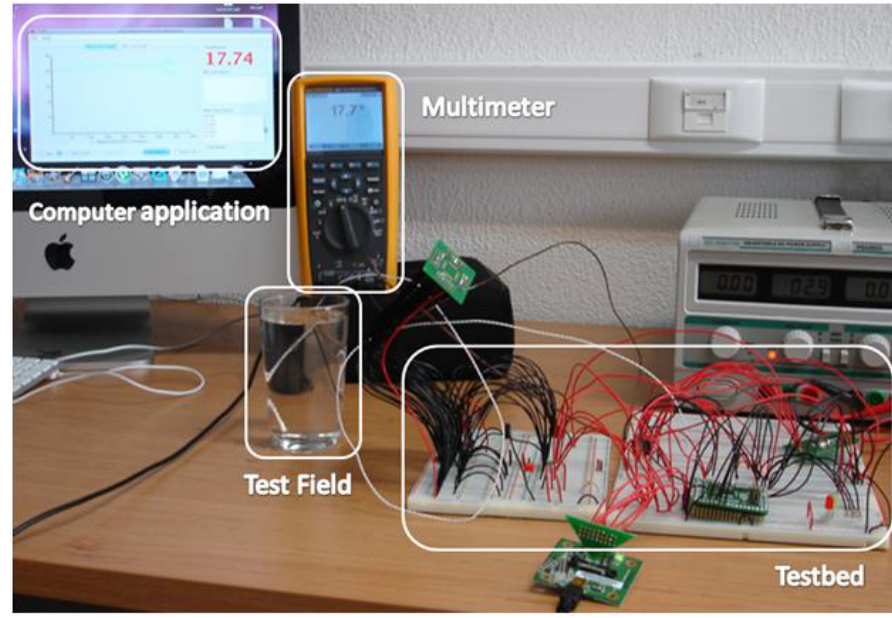
Figure 6. Experimental testbed for sensor validation of temperature